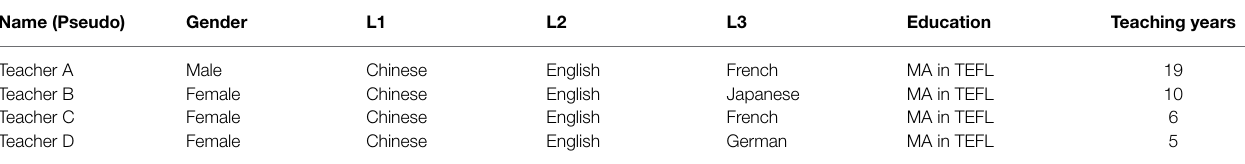
TABLE 1 | Participants: EFL teachers. Name (Pseudo)